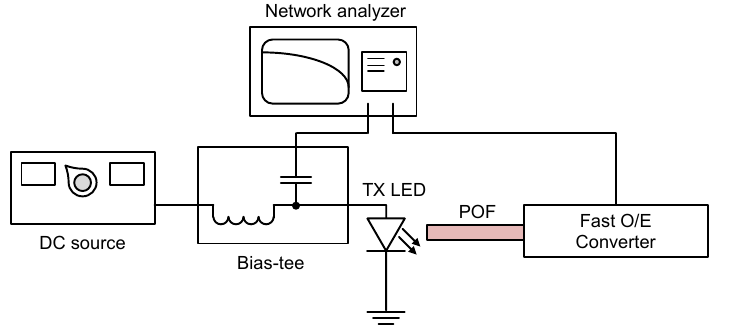
Figure 12. Measurement setup for measuring the bandwidth of the LEDs as a transmitter.